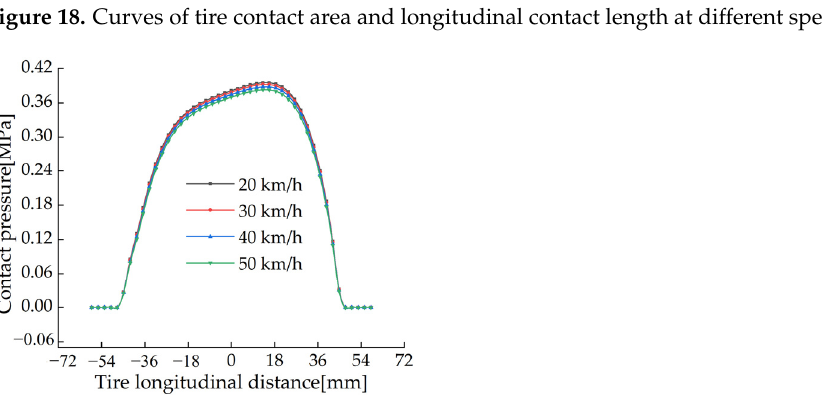
Figure 20. Radial displacement curves at different speeds. 4.4. The Effects of Different Wear Amounts on the Contact Patch In this section, the inflation pressure is 0.241 MPa, the load is 3000 N and speed is 30 km/h. The thickness of the tire tread is total 8 mm and the paper only takes into account the change in the geometry without considering the change in the mechanical properties. Assuming that tire is uniformly worn, the range of the amount of tread wear is [0, 6 mm]. When the wear amount is 0 mm, the shape of the tire is similar to an ellipse, and the long axis of the ellipse slightly increases with the increase of wear amount and the short axis decreases slightly, as shown in Figure 21. It can be seen from Figures 21 and 22 that with the increase of the tire wear amount, the ground contact area of the tire generally tends to increase. The length of the tire longitudinal contact patch decreases as the amount of tire wear increases. This is due to the tire radius decrease as the amount of tire tread wear increases, while the contact angle does not change, resulting in a decrease in the length of